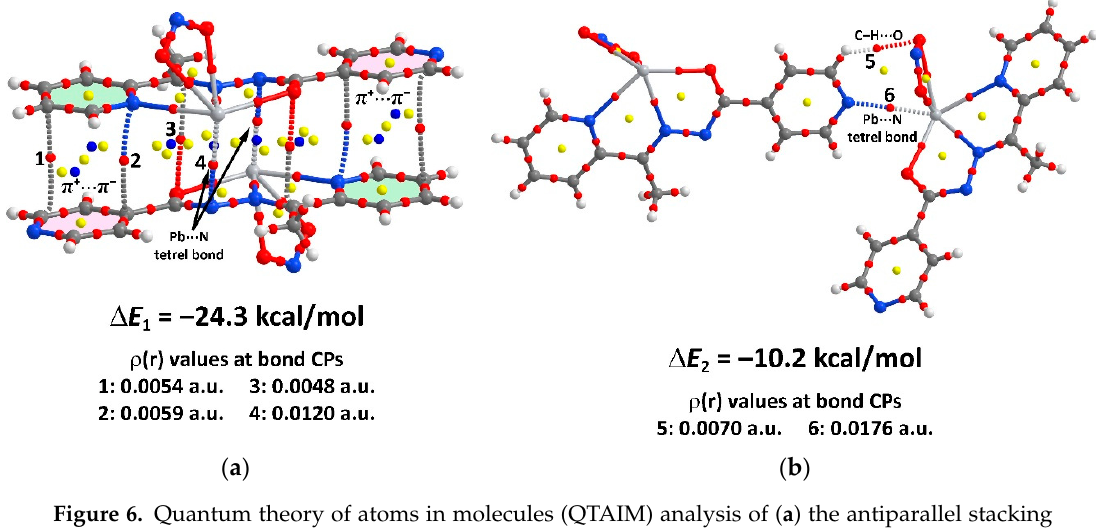
Figure 6. Quantum theory of atoms in molecules (QTAIM) analysis of ( a ) the antiparallel stacking dimer in [PbL(NO 2 )] n as a combination of the Pb ⋯ N=C(O) tetrel bonds and π + ⋯ π − interactions and ( b ) of two basic coordination units in [PbL(NO 2 )] n forming a Pb ⋯ N 4-Py tetrel bond and C–H ⋯ O bridging interaction. Bond, ring, and cage critical points are represented by red, yellow, and blue spheres, respectively. Bond paths connecting bond critical points are represented by dashed lines. Δ E = accumulated dimerization energies. ρ (r) = densities at the bond critical points.